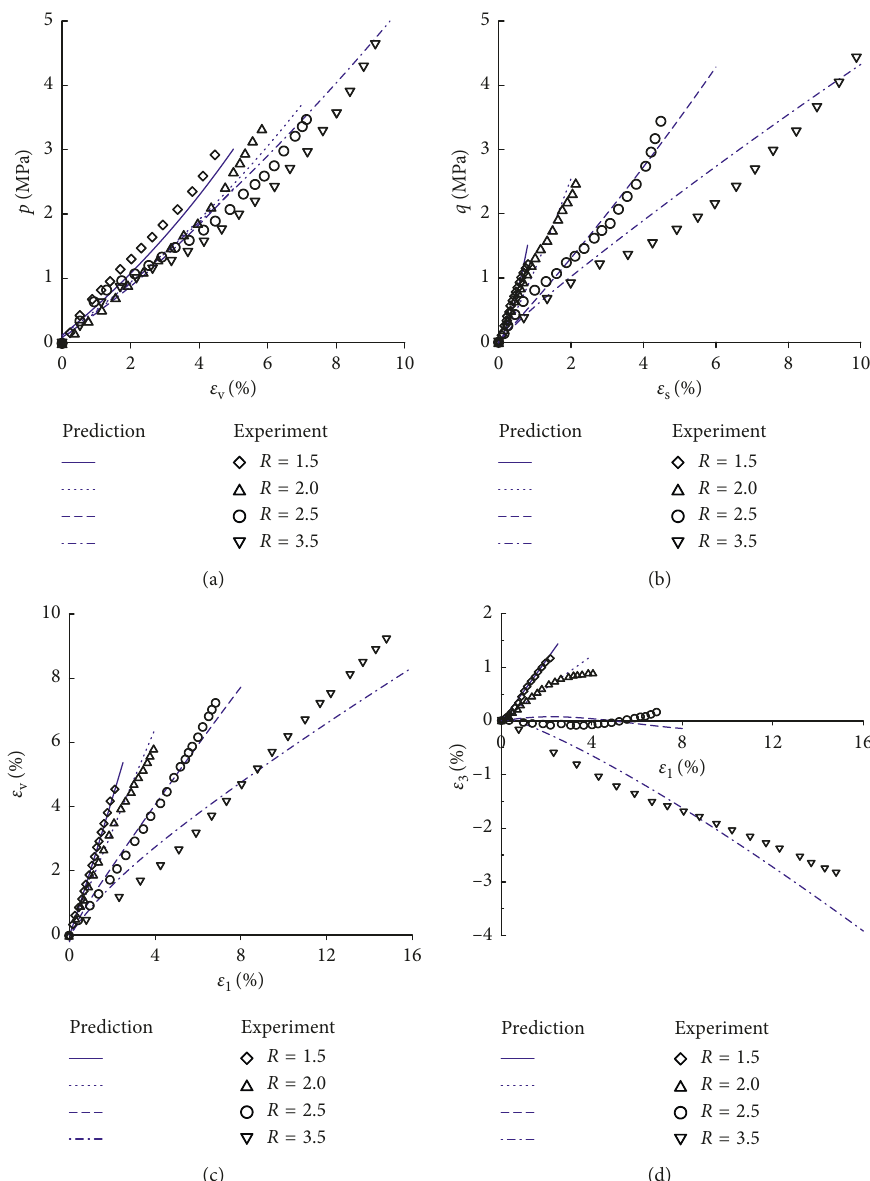
Figure 12: Prediction results of CR test based on improved dilatancy equation. (a) Spherical stress-volume strain curve. (b) Deviatoric stress-deviatoric strain curve. (c) Volumetric strain-axial strain curve. (d) Radial strain-axial strain